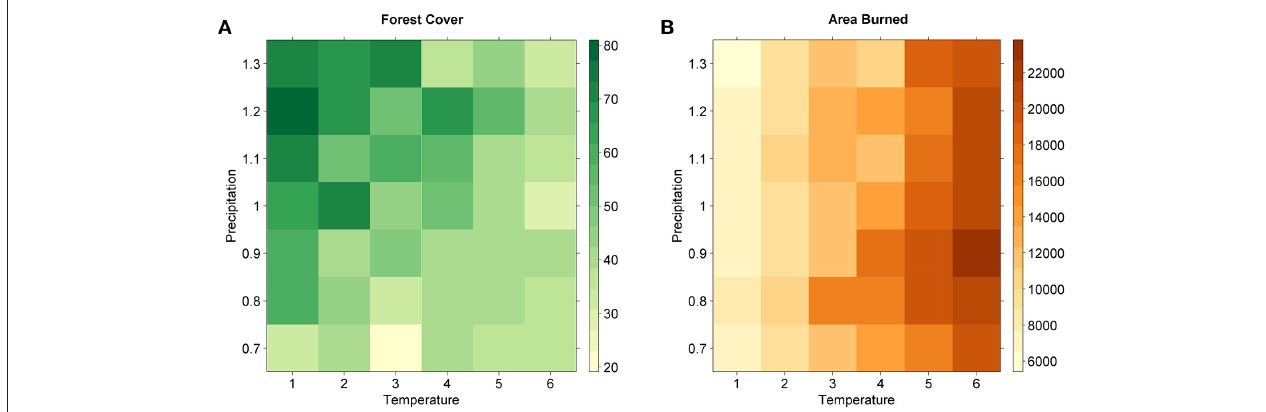
FIGURE 7 | Forest cover ( A , percent of simulation area) and area burned ( B , ha) simulated for Yellowstone National Park, Wyoming, U.S., for scenarios combining warming of 1–6 degrees Celsius ( ◦ C) and precipitation change of 70–130%. Forest cover and area burned responses for each scenario are means across simulation periods and replicates. Adapted from Keane and Loehman